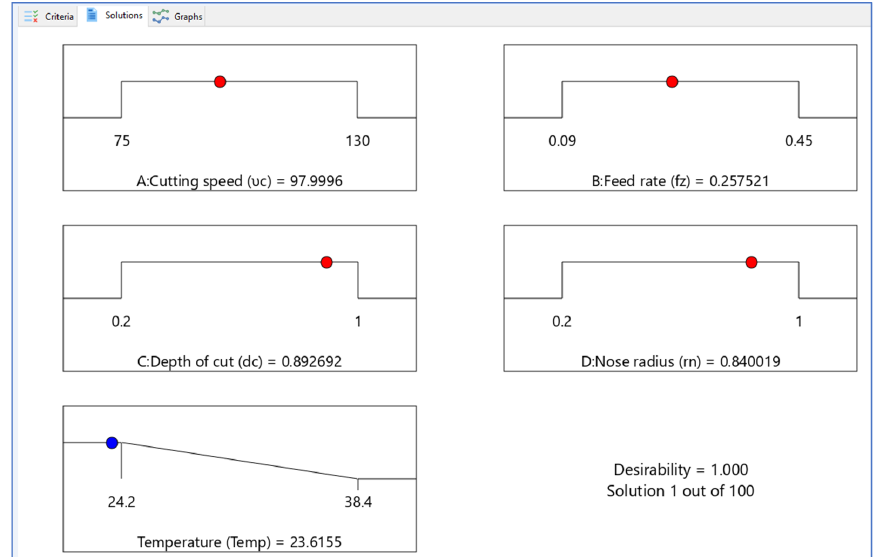
Figure 13. Ramp function graph of desirability.